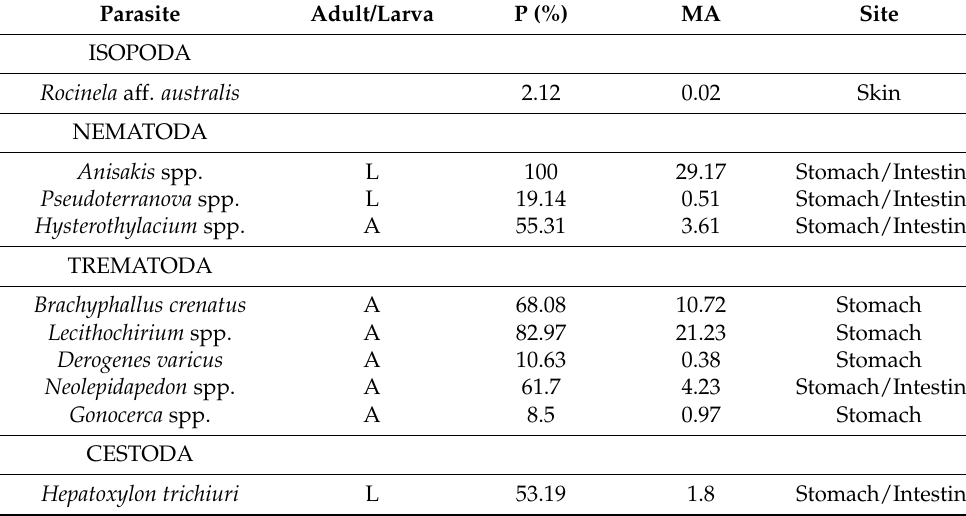
Table 1. Maturity, prevalence, mean abundance of infection, and parasite collection site of specimens present in D. eleginoides captured in waters of the south-central zone of